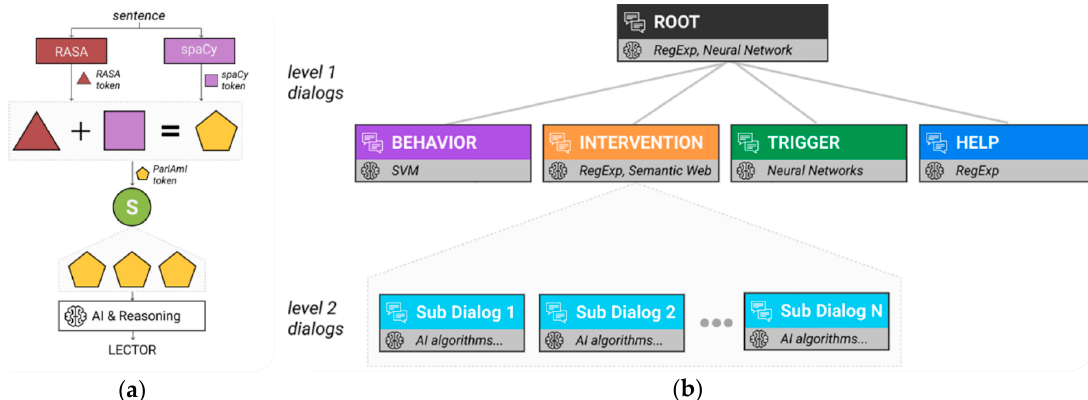
Figure 6. ( a ) The analysis pipeline: Rasa & spaCy process a sentence and their outcomes are combined with context-sensitive data to generate a valid rule; ( b ) ParlAmI’s hierarchical decision-making